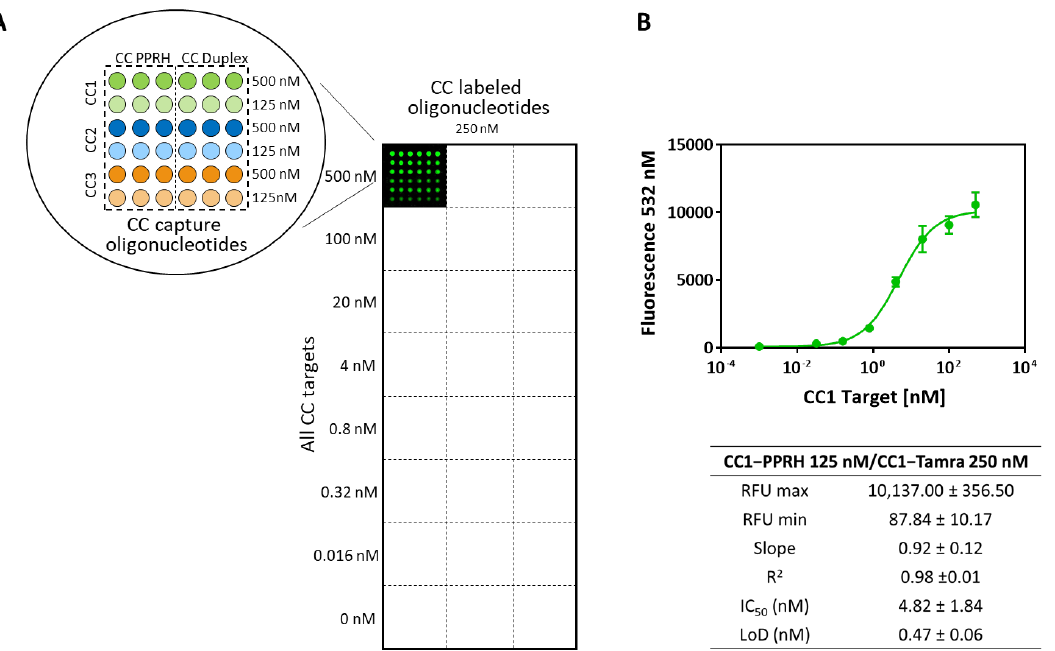
Figure 4. Microarray system designed to test simultaneously (multiplex) all three CC oligonucleotide pairs assayed in both formats (PPRH and duplex clamp). ( A ): Scheme of the chip organization and the concentrations used to build standard curves for each CC pair are shown together with a fluorescence image of a microarray well. ( B ): Calibration curve obtained for the CC1 pair and the corresponding analytical parameters of this sigmoidal curve obtained in a multiplex microarray assay (RFU: relative fluorescence units) are also plotted. All standard curves obtained were designed to record at least 3 spot replicates for each concentration value.